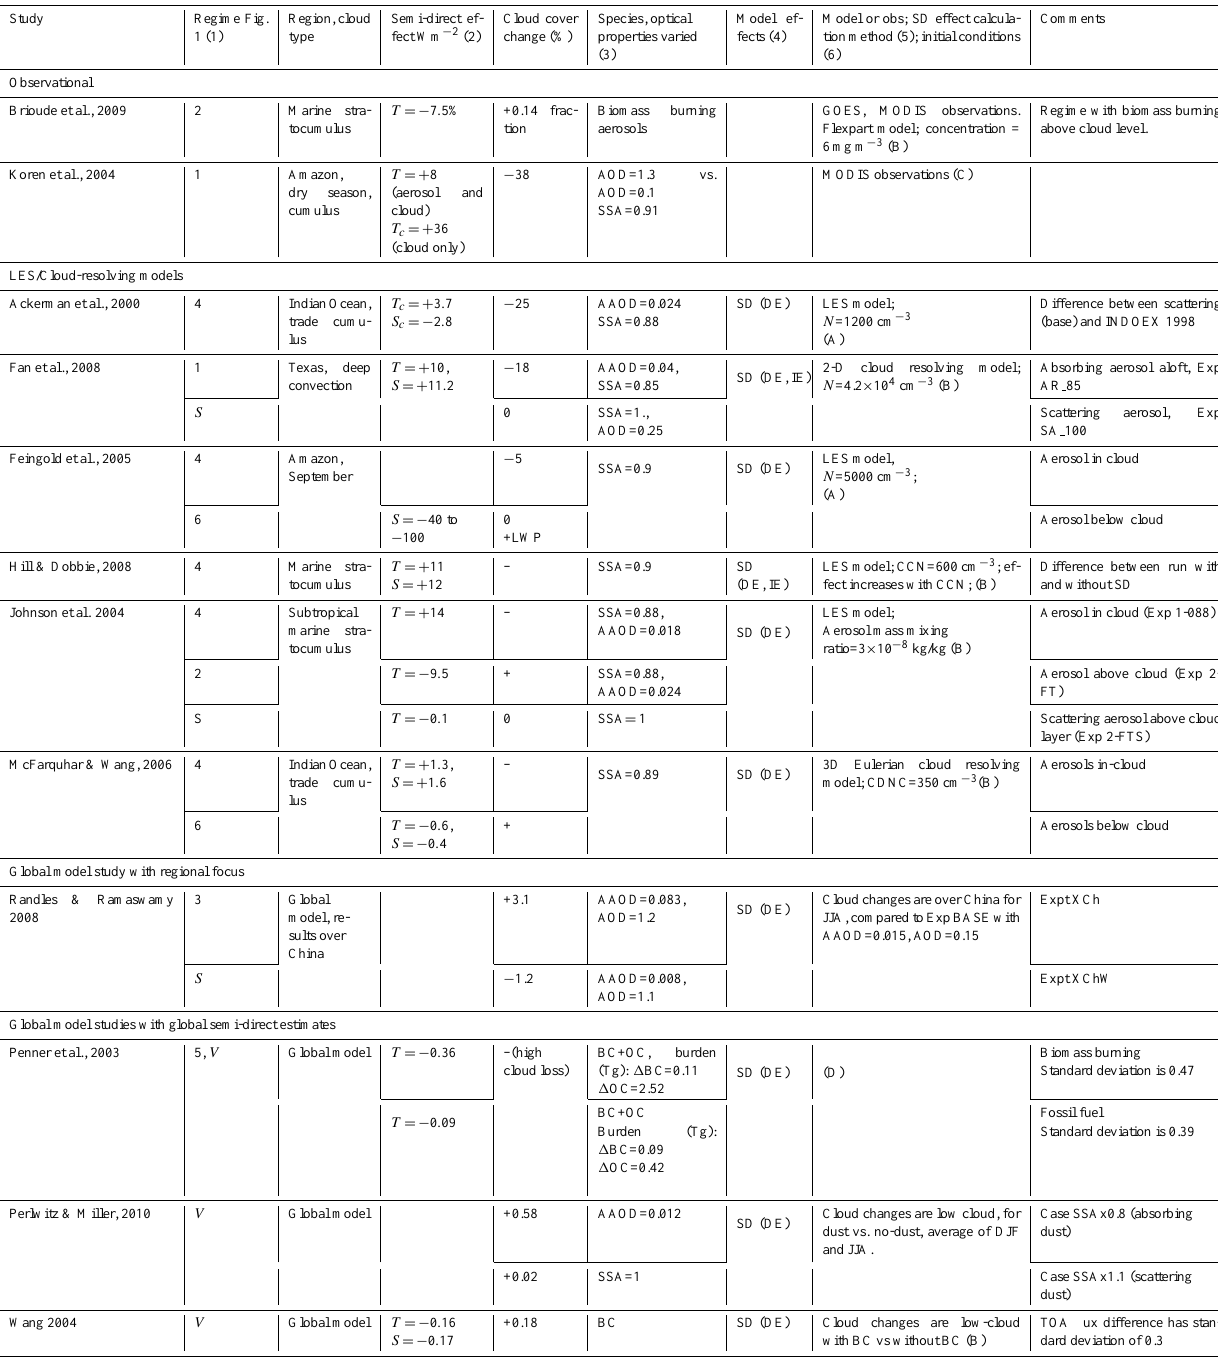
Table 1. Summary of studies that provide semi-direct effect estimates, organized by study type (Observational, cloud-scale model, global model, etc.) and then